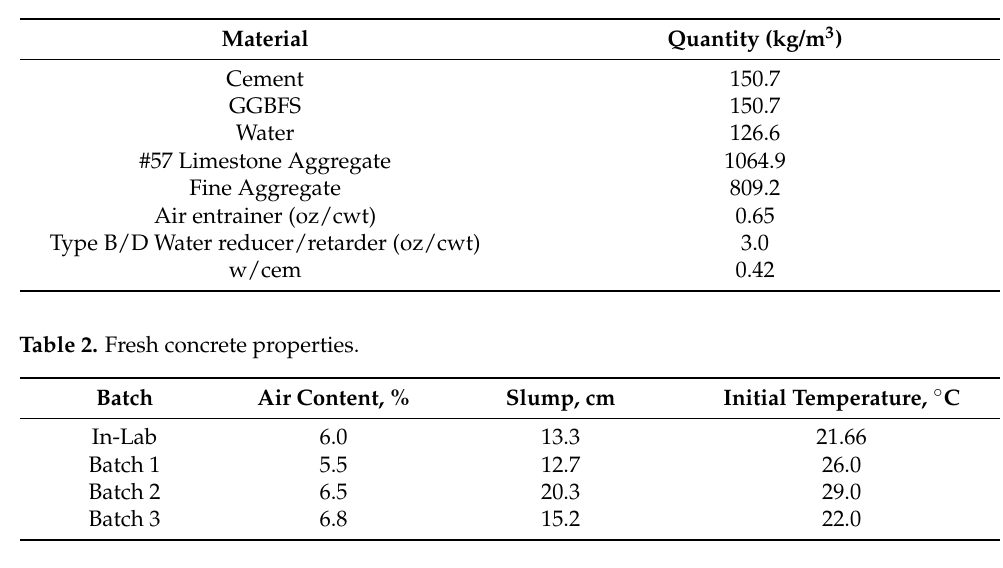
Table 1. 50% GGBFS replacement mix design.